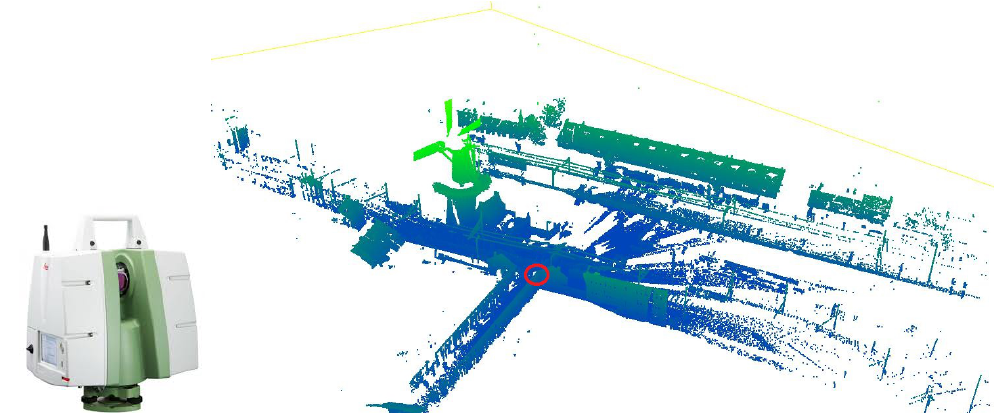
Figure 1: Left; Leica C10 laser scanner. Right; Point cloud obtained by the laser scanner. The red marker shows the scan station position.